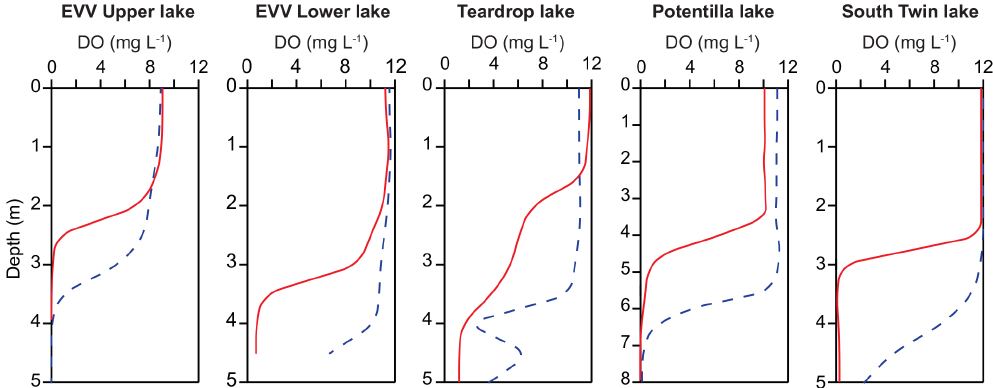
Figure 5. Profiles of DO under open-water conditions in 2012 (red solid line) and 2013 (blue dashed line).